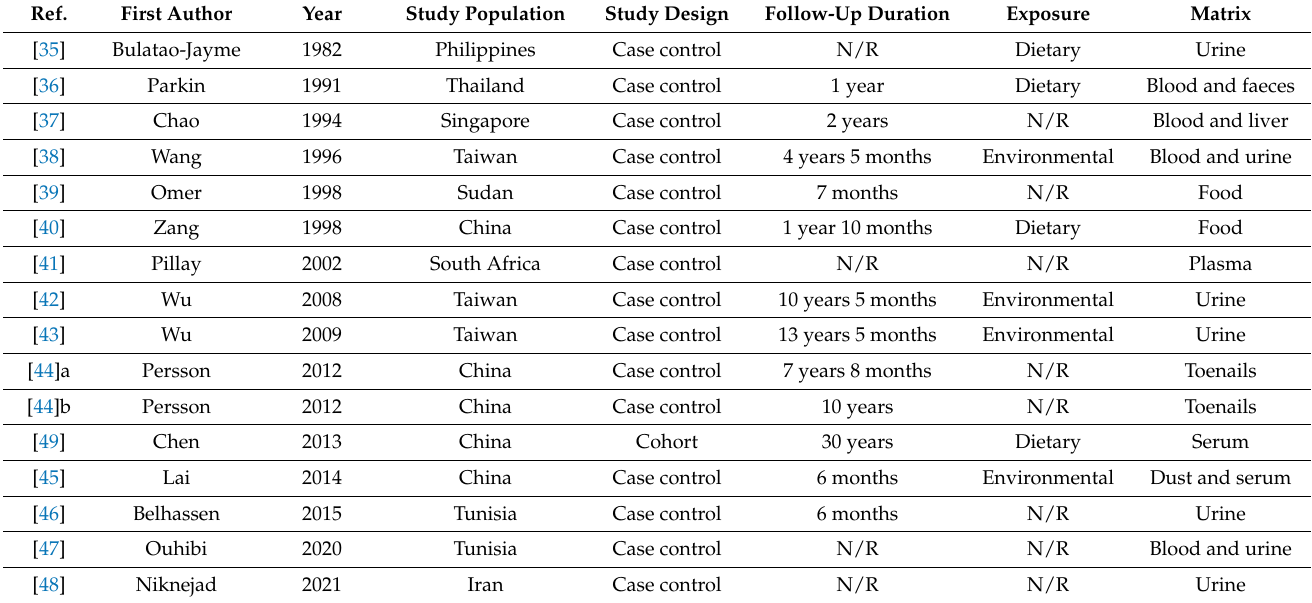
Table 1. Characteristics of studies on association between mycotoxins linked mutations and can- cer risks.